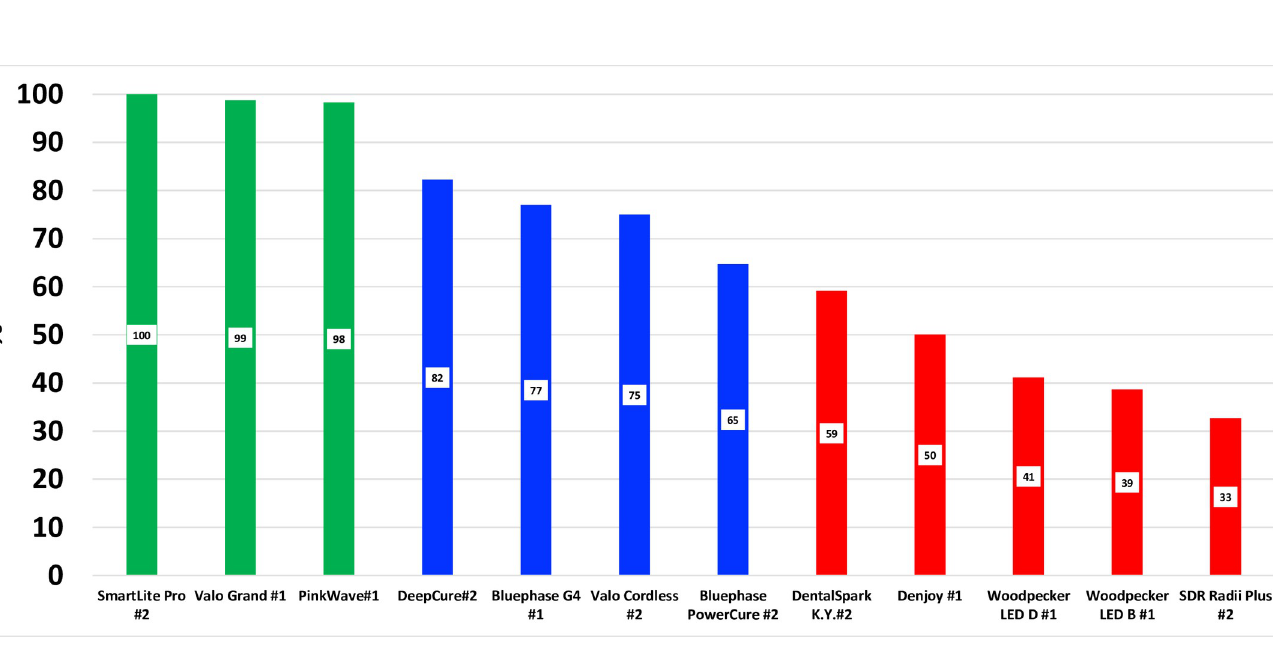
PLOS ONE | https://doi.org/10.1371/journal.pone.0267359 July 8,